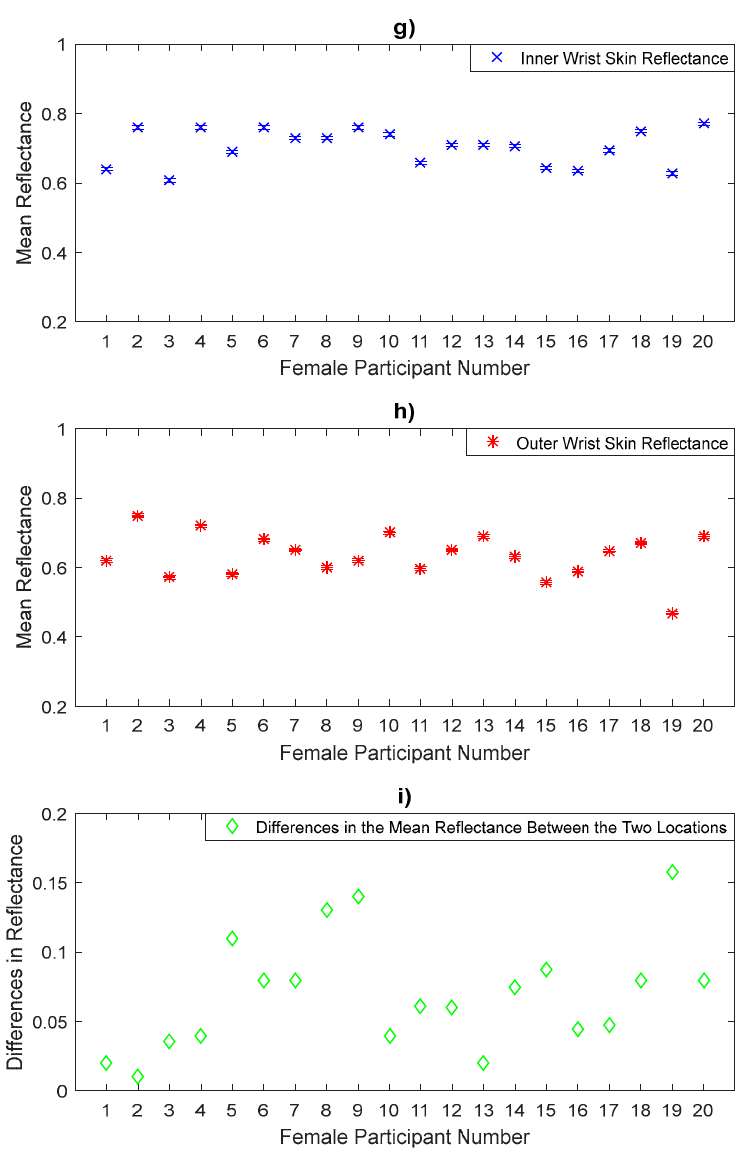
Figure 7. Measurements of human skin reflectance on the inner wrist ( g ) and the outer wrist ( h ) for a sample of 20 female participants. The mean differences in reflectance values between the two locations ( i ) are in the range of 0.01 to 0.158.